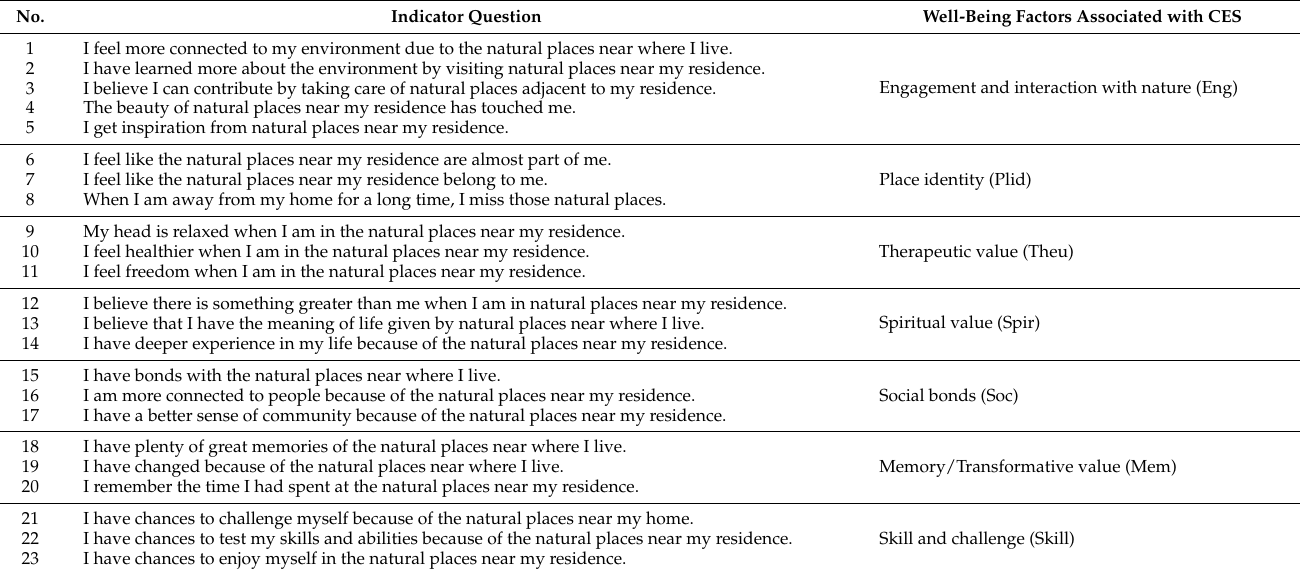
Table A1. The adapted indicator and factor used in the well-being instrument